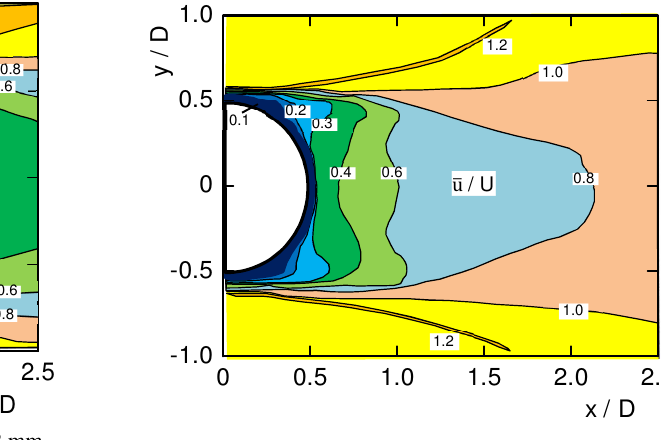
(a) the forced reattachment ( D = 40 mm, d = 2 mm, G = 6 mm, a = 121°, Re = 1.6 · 10 4 ) . Fig. 3 . Contours of the time-averaged velocity behind the circular cylinder .